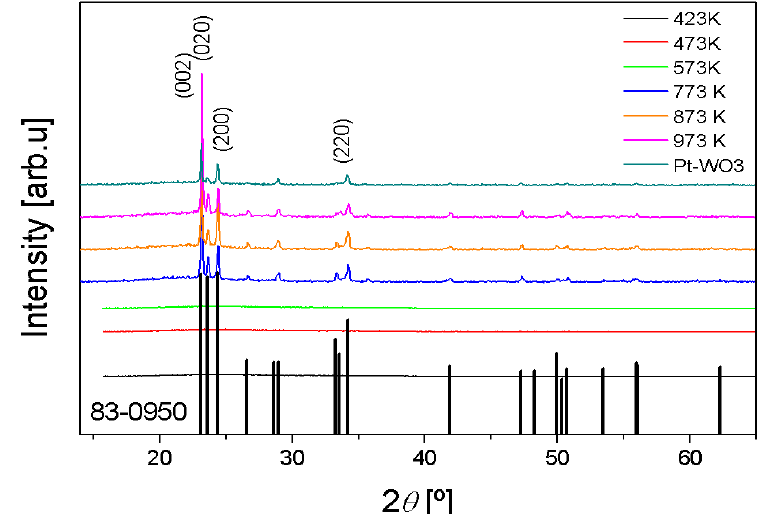
Figure 1. X-ray powder diffraction patterns of the TO films annealed in the range of temperatures from 423 K to 973 K and X-ray powder diffraction pattern of the WO annealed at 973 K with Pt